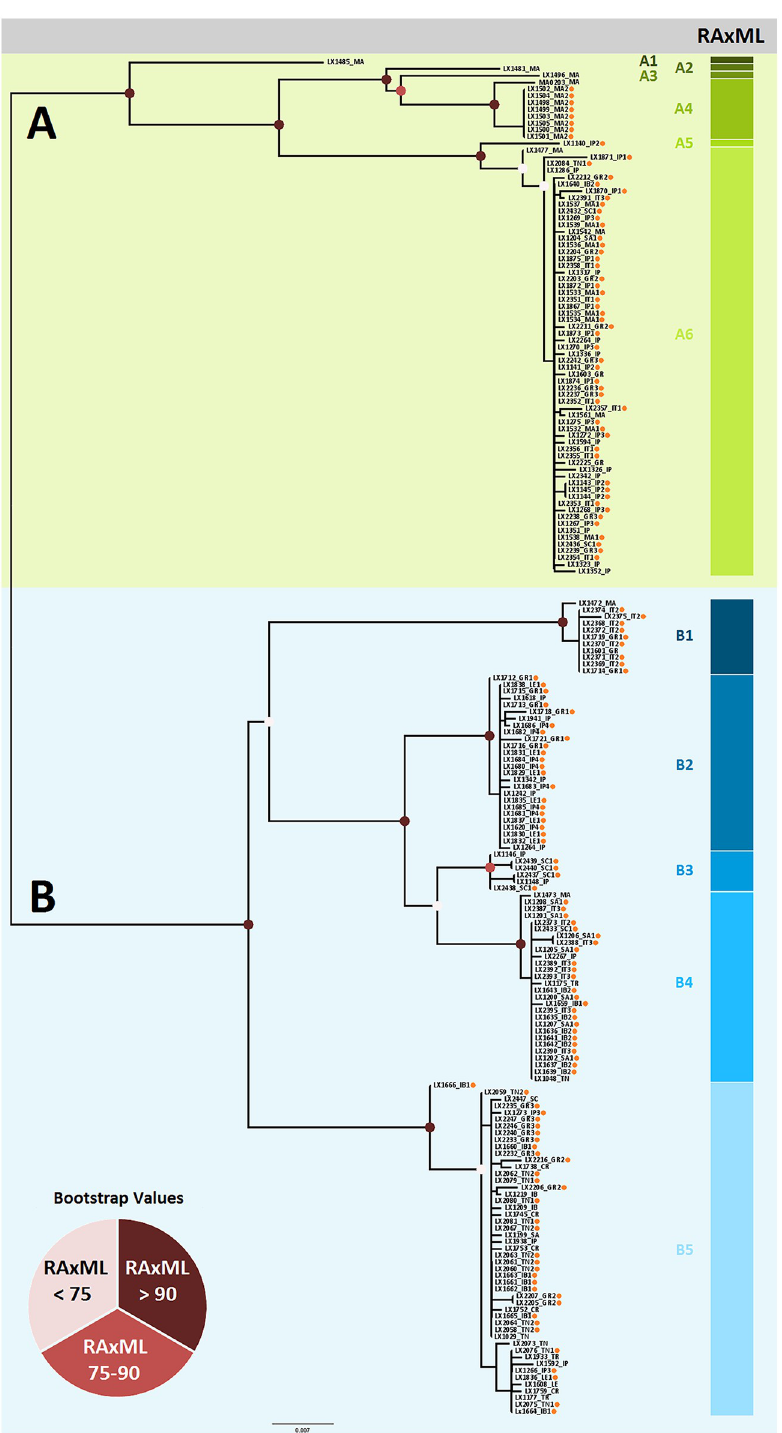
Fig 2. Maximum likelihood tree based on the cox1 sequences. Node circles represent the bootstrap values as shown in the legend. The clade A is indicated by green, and the clade B by blue. Colored bars on the right indicates the different lineages from each clade. Spots on the terminals indicates individuals with microsatellites information. Abbreviations: CR (Crete), GR (Greece), IB (Balearic Islands), IP (Iberian Peninsula), IT (Italy), LE (Israel), MA (Morocco), SA (Sardinia), SC (Sicily), TN (Tunisia), TR (Turkey). The position of the root was estimated implicitly in BEAST v.1.7.4 and used for rooting RAxML trees.